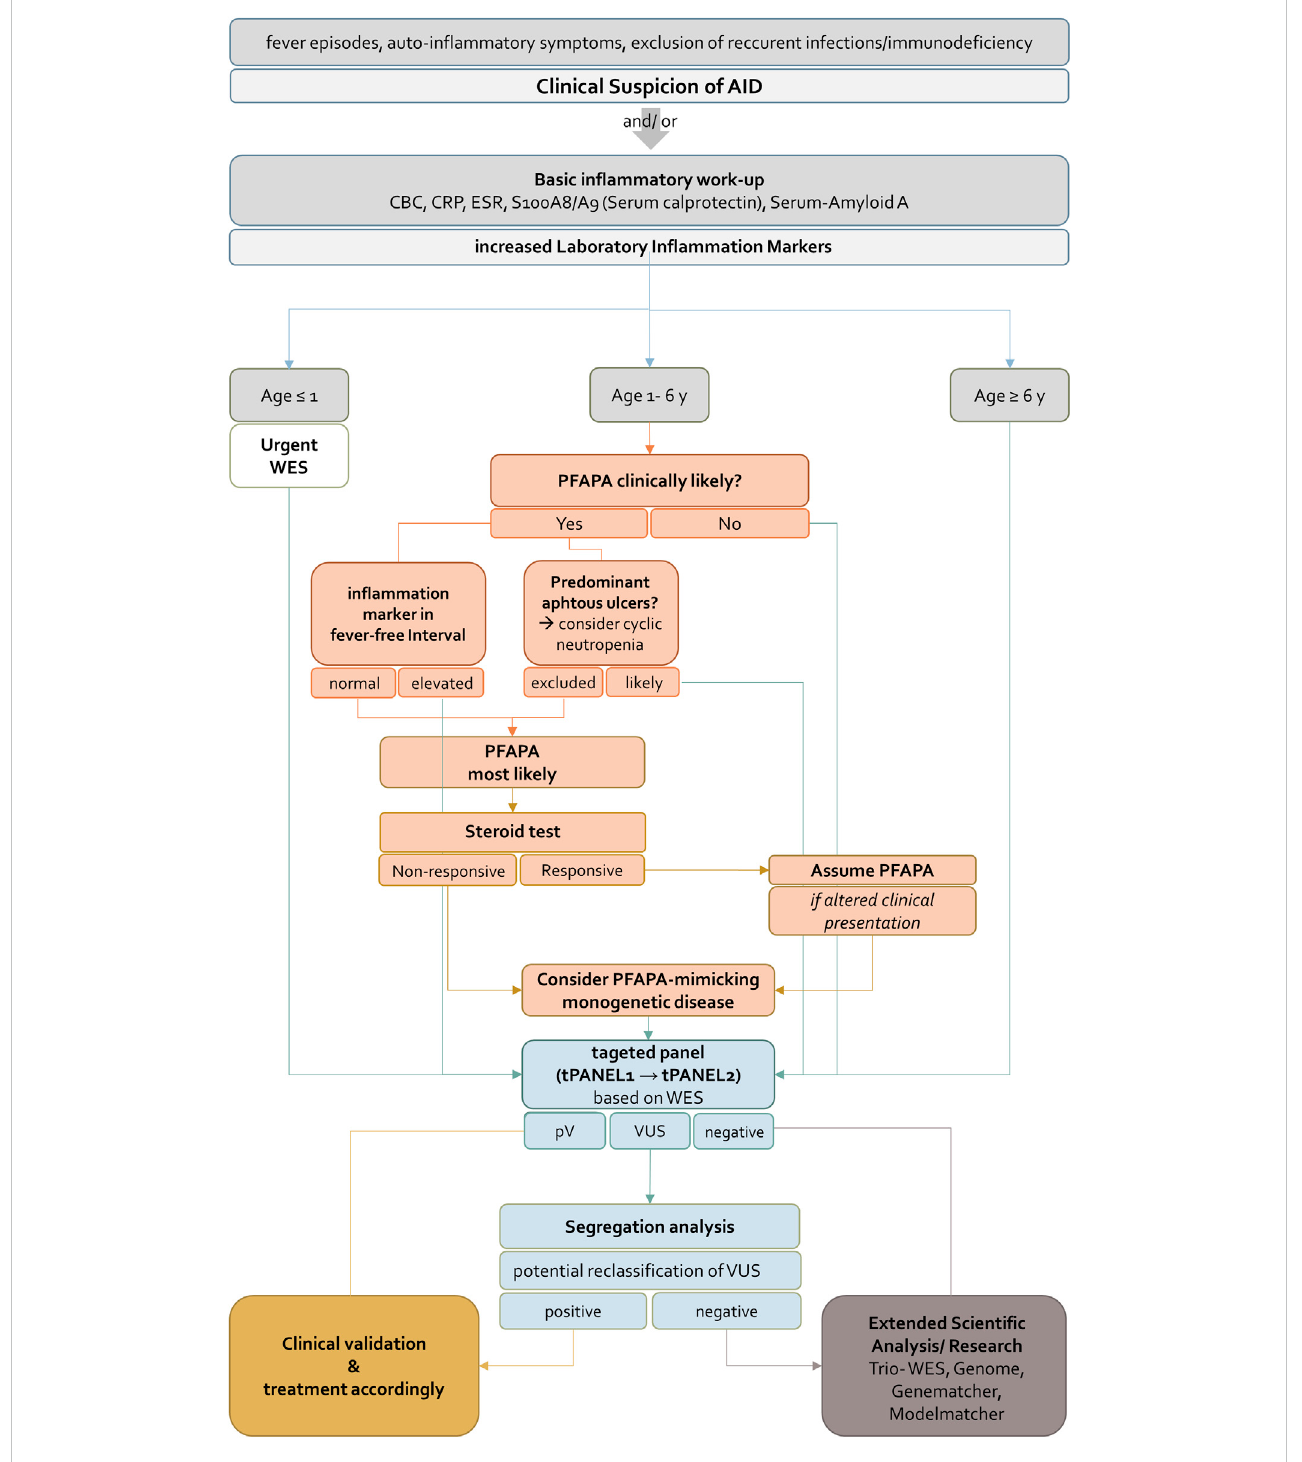
FIGURE 5 Flowchart for diagnosis, treatment and genetic evaluation of patients with suspected AID. AID should be suspected if patients present with fever episodes and auto-in fl ammatorysignsandsymptoms.IfCBC,CRP,ESR,S100A8/A9(Serumcalprotectin)andSerum-AmyloidAareincreasedthefurtherapproachdependsonthe ageofthepatient.Forpatientsyoungerthan1 yearorolderthan6 yearsWESshouldberequestedimmediately.Accordingtoclinicalguidelinespatientsbetweenone and6 yearsPFAPAsyndromeshouldberuledoutina fi rststep.Ifin fl ammationmarkersinfever-freeintervalsarenotelevatedandcyclicneutropeniaisexcluded in patients with oral ulcers, PFAPA syndrome is most likely. A response to a steroid test con fi rms the diagnosis. A non-responsive steroid test indicates a PFAPA- mimickingmonogeneticdiseaseandWESshouldbeperformed.Forallchildrenidenti fi cationofpathogenicvariant(s)intPANELentailsclinicalvalidationandtreatment according to the disease. For negative sequencing results an extended scienti fi c analysis (e.g. Trio- WES, Genome, analysis of genes of uncertain signi fi cance) is recommended. Variants of unknown signi fi cance can be further evaluated by segregation analysis. Con fi rmation of variants as having arisen de novo may result in reclassi fi cation under ACMG guidelines. AID, autoin fl ammatory disease, CBC, complete blood count, CRP, C-reactive protein, ESR, erythrocyte sedimentation rate, WES, whole exome sequencing, PFAPA, Periodic Fever, Aphthous Stomatitis, Pharyngitis, Adenitis, pV, pathogenic variant, VUS, Variant of unknown signi fi